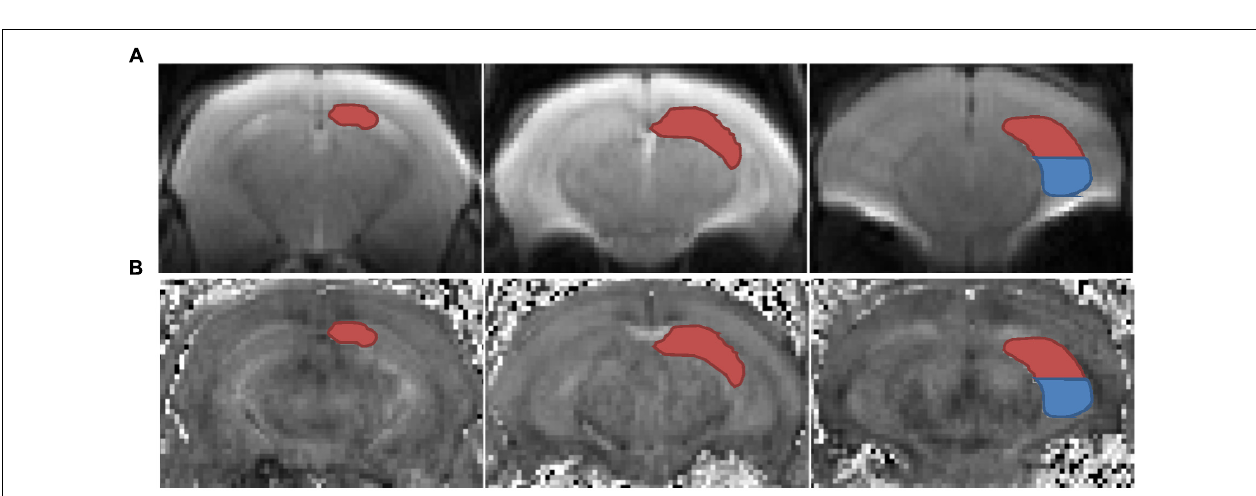
FIGURE 1 | Social interaction test. (A) Schematic diagram of the social interaction arena. (B) Susceptible mice had a significantly lower SI ratio. (C) Susceptible mice had a non-significantly higher corner ratio. (D) Three groups displayed a comparable distance moved in the two separate trials. Data were presented as mean ± SEM; ∗ P < 0.05, ∗∗ P < 0.01.